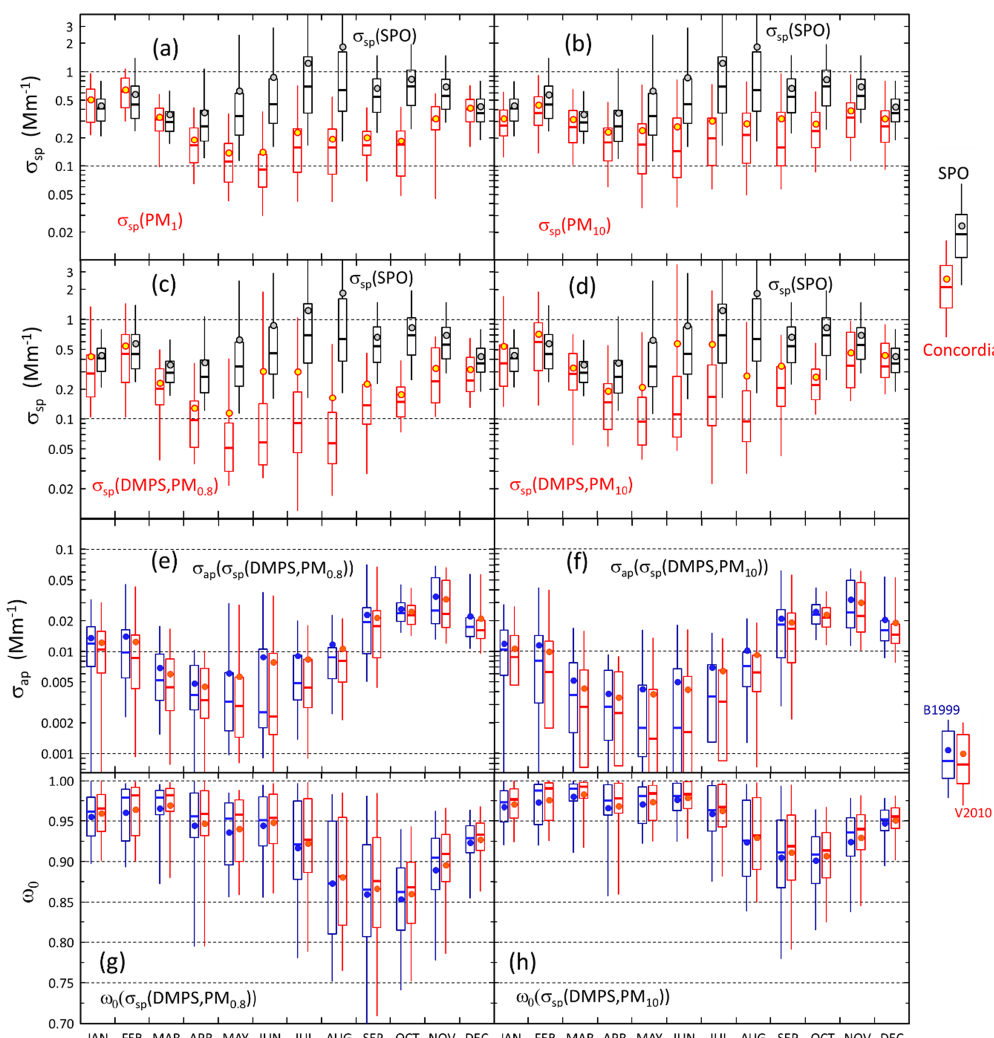
Figure 9. Seasonal cycles of scattering and absorption coefficients and single-scattering albedo. (a) Scattering coefficient ( σ sp ) calculated from the sums of analyzed ion concentrations in PM 1 filters at λ = 550nm, (b) σ sp calculated from the sums of analyzed ion concentrations in PM 10 filters, (c) the lower estimate of σ sp = σ sp (DMPS,PM 0 . 8 ), (d) the upper estimate of σ sp = σ sp (DMPS,PM 10 ), (e) absorption coefficient σ ap calculated with the algorithms of B1999 and V2010 (Eqs. 17 and 18) by using the σ sp lower estimate for scattering correction, (f) σ ap calculated with the two algorithms by using the σ sp upper estimate for scattering correction, (g) single-scattering albedo ω o calculated by using the σ sp lower estimate for both σ sp and σ ap , and (h) ω o calculated by using the σ sp upper estimate for both σ sp and σ ap